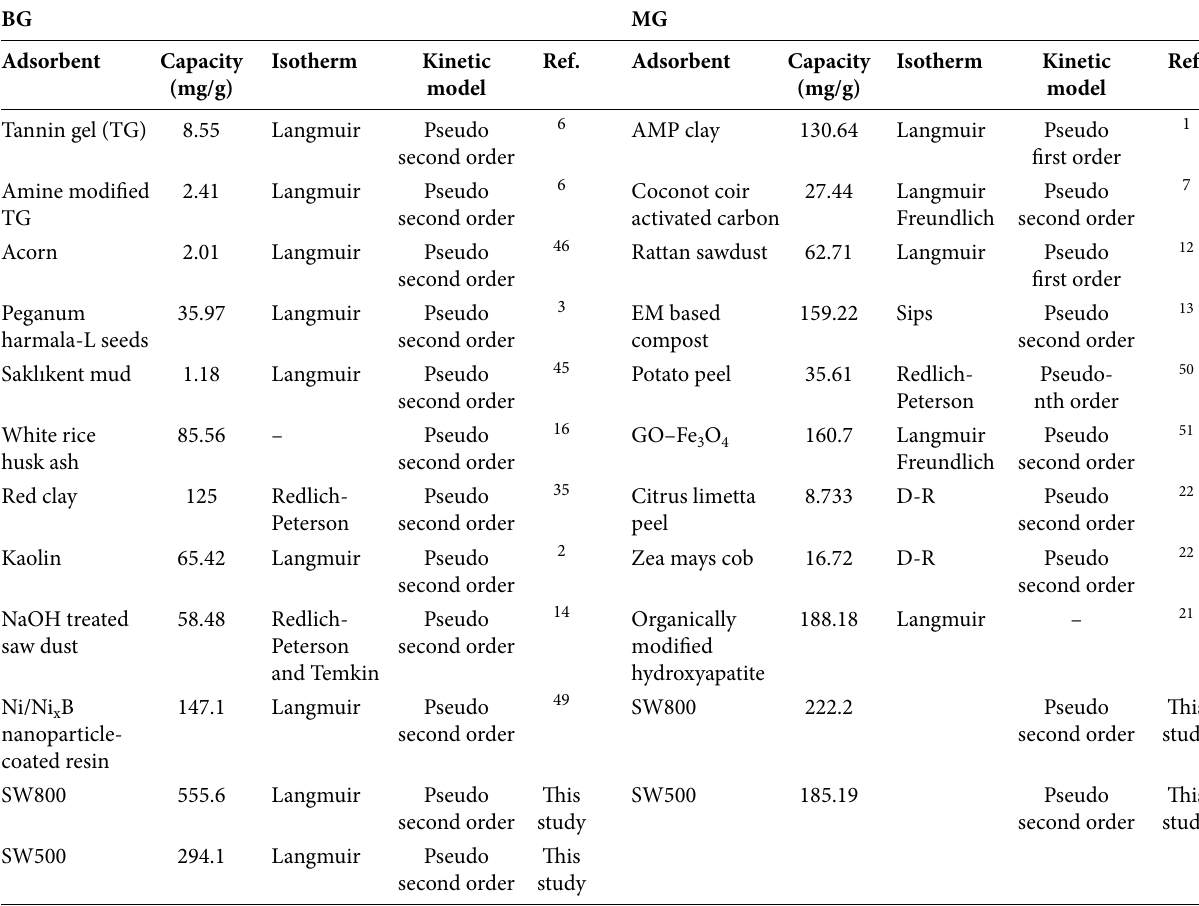
Table 4 Comparison of the maximum adsorption capacities of BG and MG with the reported adsorbents in the